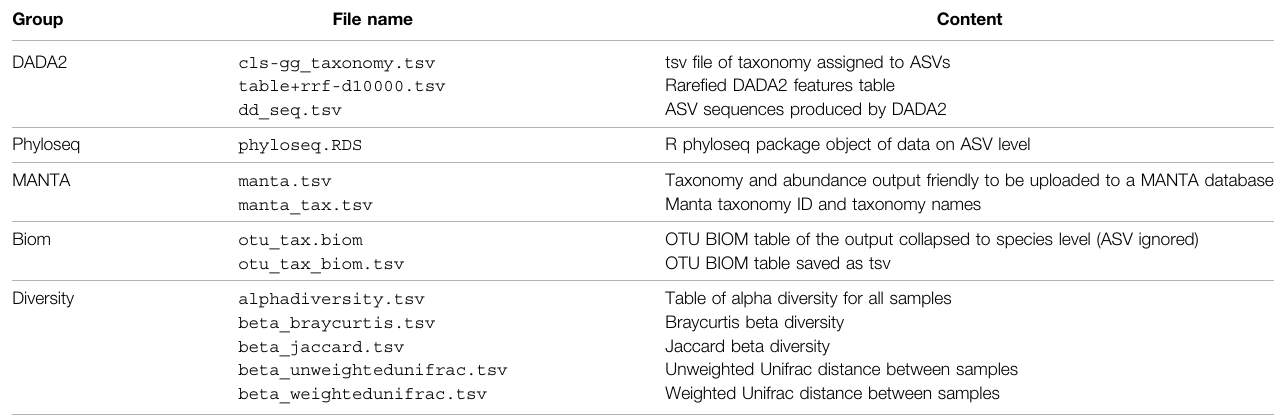
Table of alpha diversity for all samples